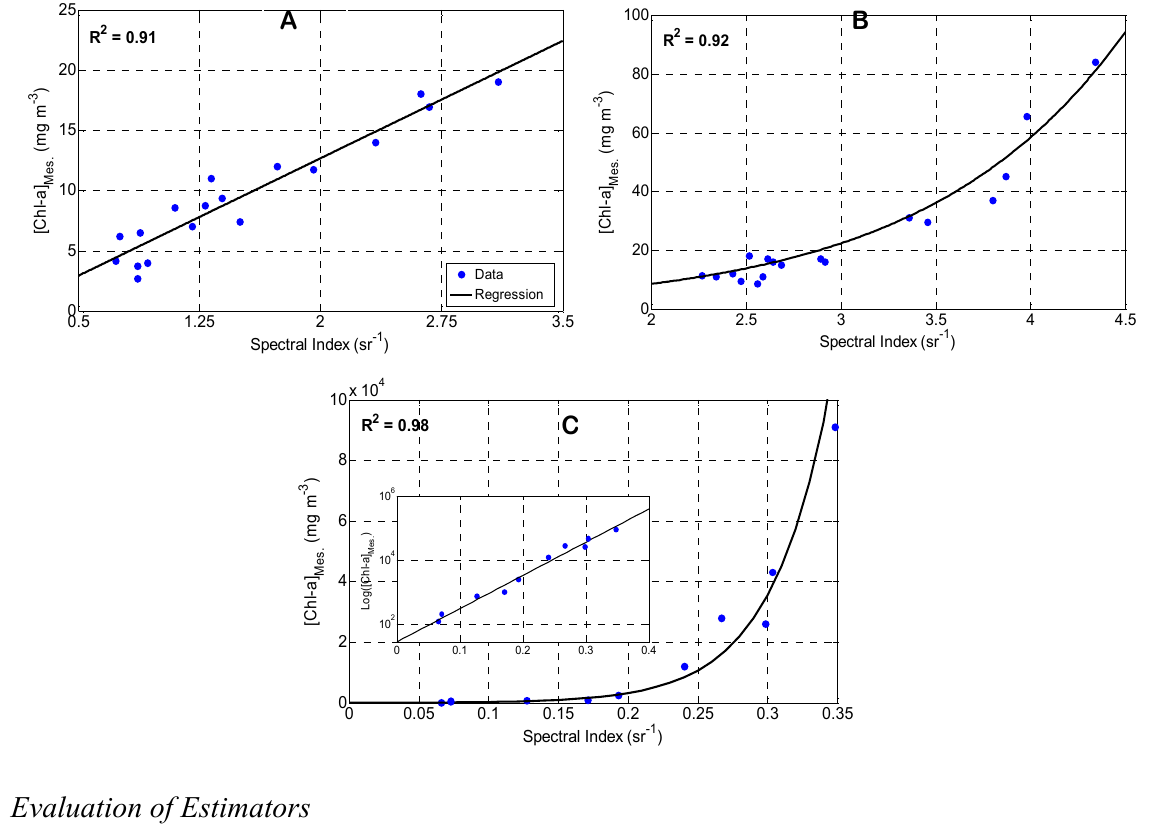
Figure 8. Results of multivariate regression adjustments between the measured chlorophyll-a concentrations and the return signals of MODIS images for the three blooming classes: ( A ) Low; ( B ) Moderate; ( C ) High Chl-a concentrations. The scale of the y-axis in the insert is logarithmic to better illustrate the